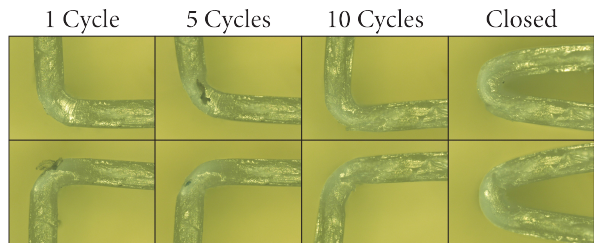
Figure 14. Cyclic behavior for acetal. Delamination is not seen, but localized thinning occurs as tensile stresses on the outside elongate the material.